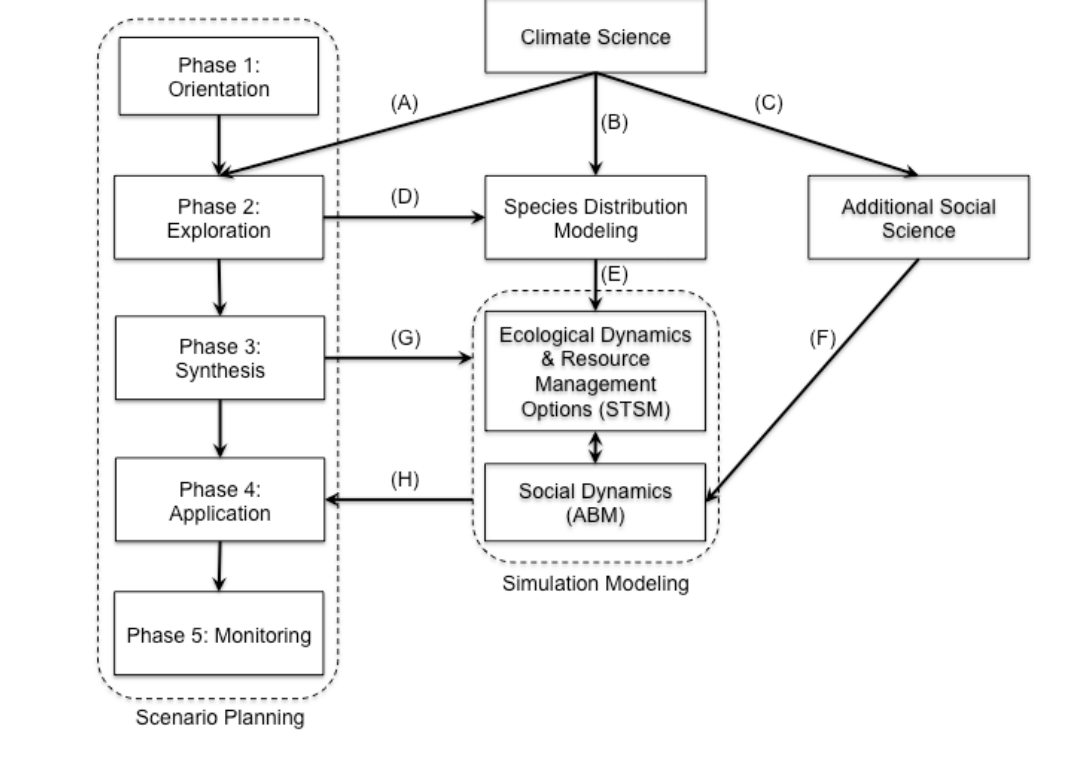
Fig. 1 . Analytical framework for integrating species distribution modeling, scenario planning, and simulation modeling (STSM: state-and-transition simulation modeling, ABM: agent-based modeling) for climate change planning. Key inputs and outputs: (A) summaries of possible climate futures; (B) gridded climate data; (C) historical climate trends and climate projections; (D) critical forces, variables, and impacts; (E) projected distributions of key species or resources; (F) resource-use decision processes and expected human responses to climate change; (G) descriptive social-ecological-climate scenarios and potential management strategies; (H) validated scenarios and outcomes of simulated management strategies. Scenario planning phases were adapted from Rose and Star